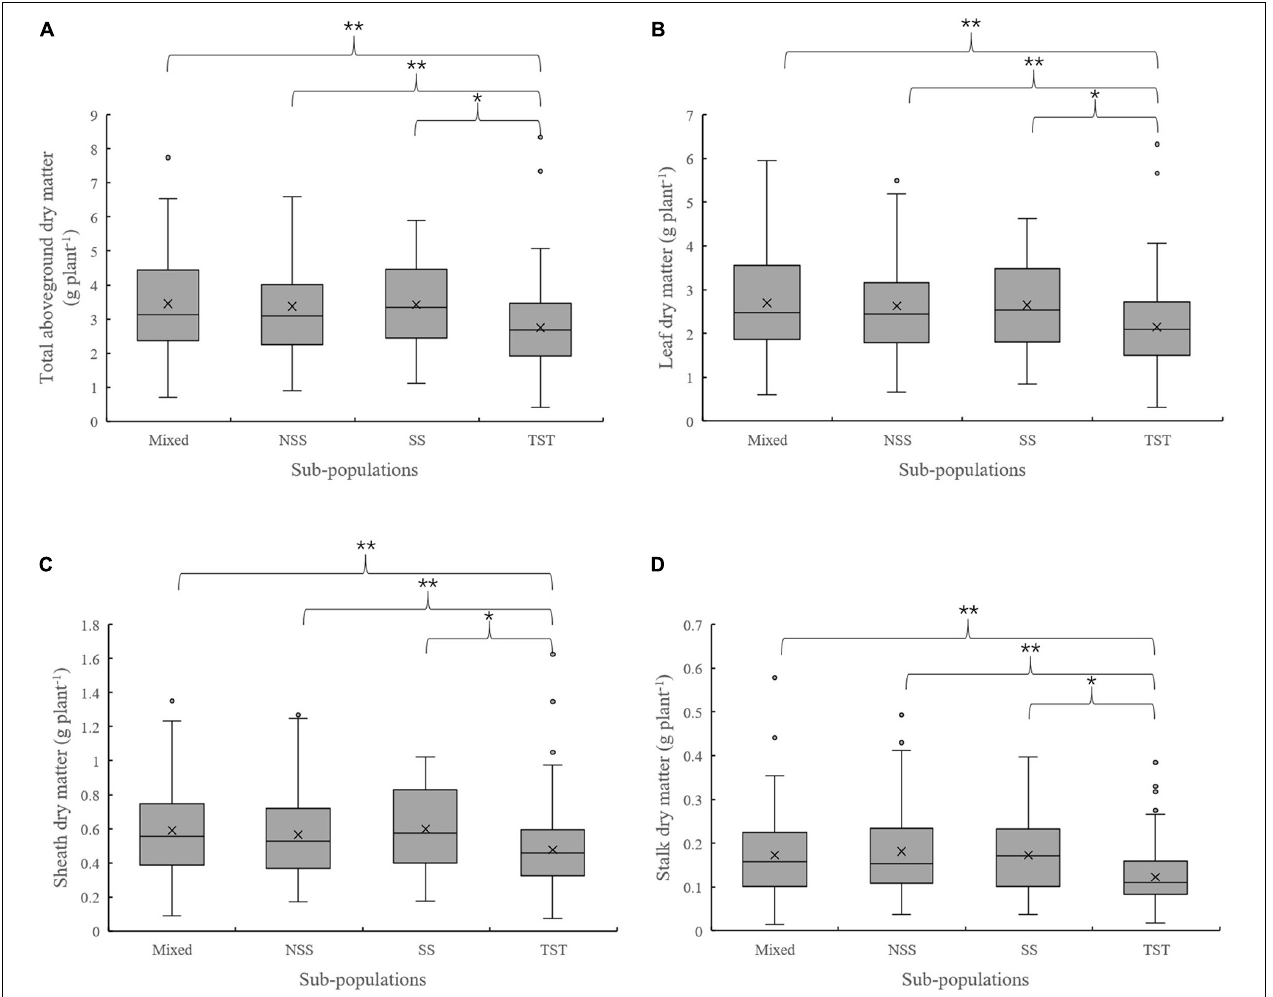
FIGURE 2 | Boxplot of the total aboveground dry matter and organ’s dry matter in different subpopulations at the V6 stage. ** denotes significant differences between subpopulations at P ≤ 0.01, * denotes significant differences between subpopulations at P ≤ 0.05. (A–D) represent total aboveground dry matter, Leaf dry matter, Sheath dry matter and Stalk dry matter in different subpopulations